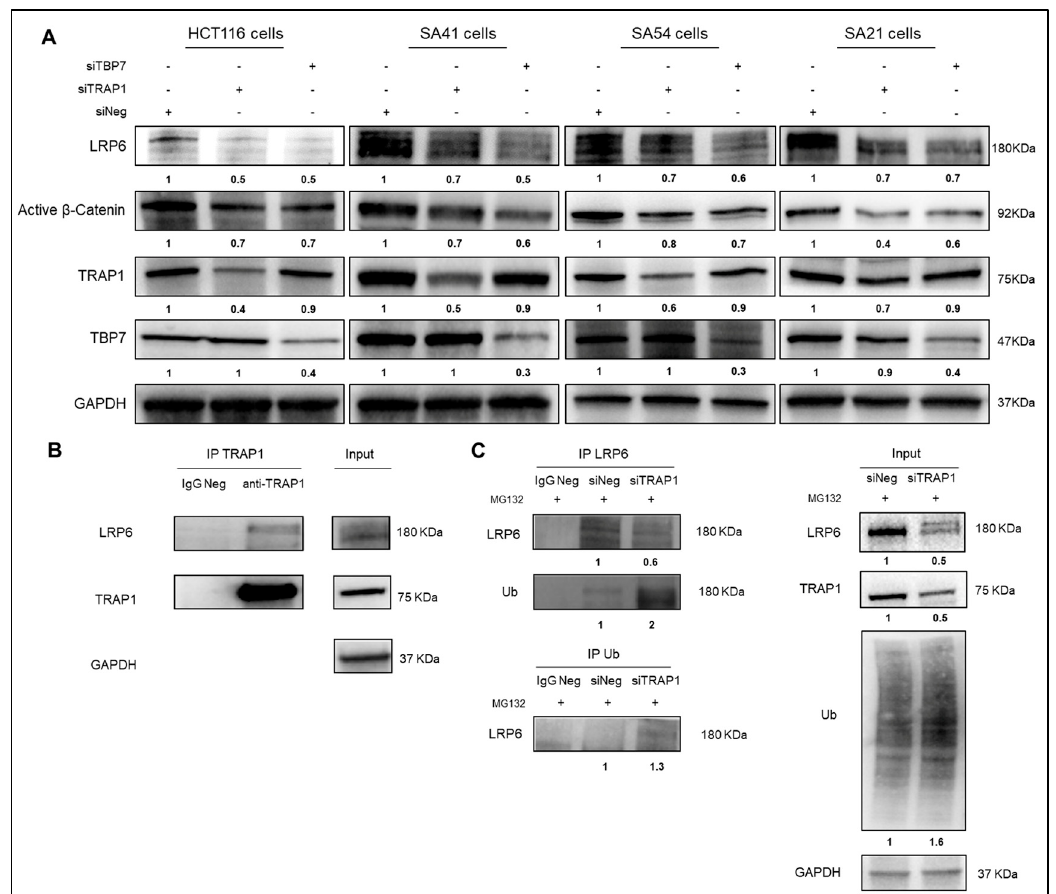
Figure 4. TRAP1 regulates LRP6 expression through a quality control by the regulation of its ubiquitination / degradation. ( A ) Total lysates from HCT116, SA41, SA54, and SA21 cells, transfected with control (siNeg) or TRAP1 / TBP7 siRNAs, were separated by SDS-PAGE and immunoblotted with indicated antibodies. ( B ) Anti-TRAP1 immunoprecipitates were obtained from HCT116 cells, separated by SDS-PAGE and immunoblotted with anti-LRP6 and anti-TRAP1 antibodies. IgG Neg, total cellular extracts incubated with nonspecific antibody. Input: Total cell lysates from HCT116 cells were separated by SDS-PAGE and immunoblotted with the indicated antibodies. ( C ) Anti-LRP6 (upper panel) and anti-ubiquitin (lower panel) immunoprecipitates were obtained from HCT116 cells transfected with control (siNeg) or TRAP1 siRNAs, separated by SDS-PAGE and immunoblotted with anti-ubiquitin (upper panel) and anti-LRP6 (lower panel) antibodies. Cells were incubated with 10 mmol / L MG132 for 2 h before cell lysis. Densitometric band intensities represent the ratios between ubiquitinated and total LRP6 bands in IPs. IgG Neg, total cellular extracts incubated with nonspecific antibody. Input: Total cell lysates from HCT116 cells transfected with control or TRAP1 siRNA were separated by SDS-PAGE and immunoblotted with the indicated